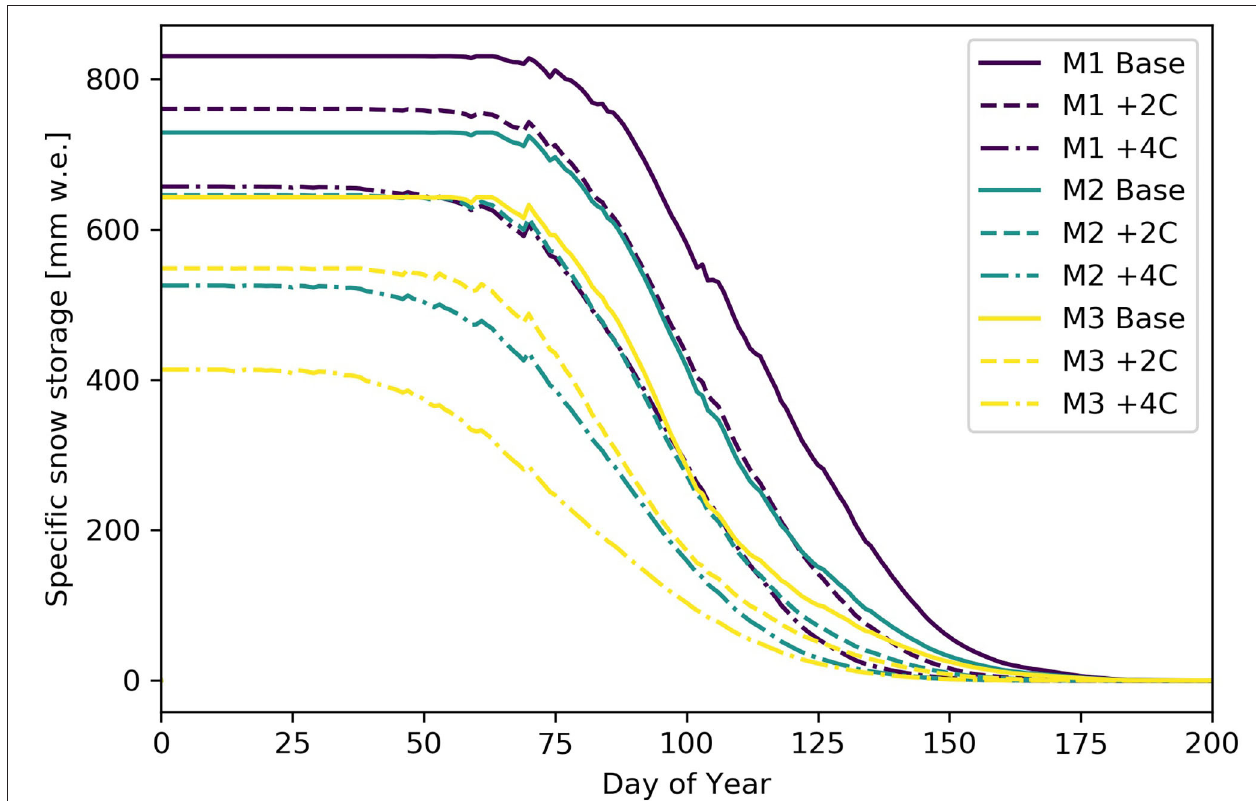
FIGURE 7 | Specific snow storage for three idealized basin hypsometries and baseline (solid), + 2 ◦ C (dashed), and + 4 ◦ C (dot-dashed) scenarios.